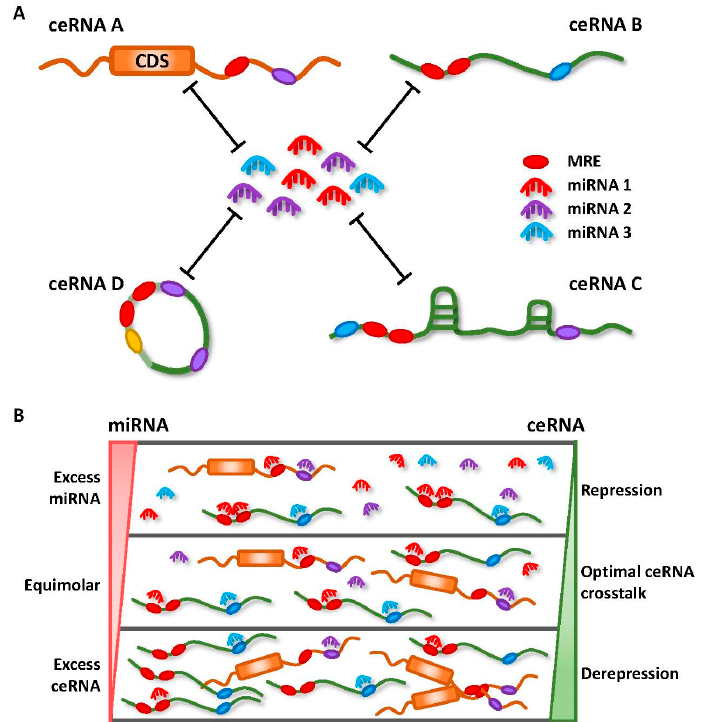
Figure 2. Competing endogenous RNA (ceRNA) networks of mRNA/miRNA/lncRNA. ( A ) miRNAs bind to specific miRNA response elements (MREs), which are found on coding (ceRNA A) and noncoding transcripts (ceRNA B, C and D) to suppress gene expression. Transcripts with MREs for the same miRNAs can compete for binding to a shared pool of miRNAs to reduce their availability (ceRNA A–D can compete for miRNA 1; ceRNA A, C, and D compete for miRNA 2; ceRNA B and C compete for miRNA 3). Transcripts with more MREs (for different miRNAs and of mixed affinities) may cooperatively bind miRNAs for more effective competition. MREs are represented by ovals that are in corresponding colors to their targeting miRNAs. ( B ) Schematic illustrating the conditions for optimal ceRNA crosstalk. Excess miRNAs compared to their targets leads to target repression, whereas, excess ceRNA molecules and low miRNA concentrations result in depression of target expression. Optimal ceRNA crosstalk occurs when miRNAs and their targets are in equimolar concentrations.